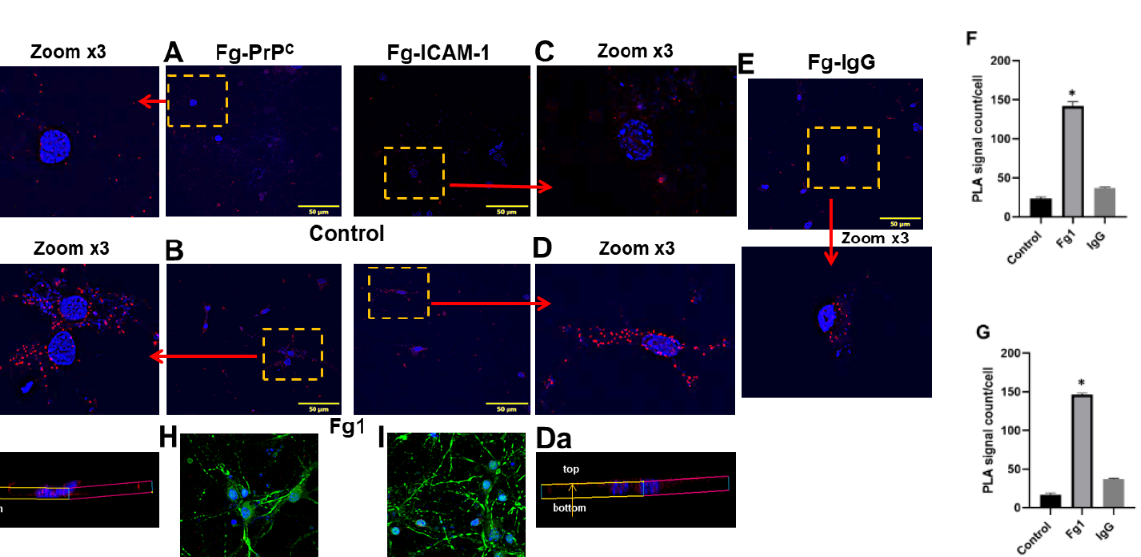
or the ICAM function-blocking antibody alone. Hirudin was present in all experimental groups to prevent the conversion of Fg to fibrin. ( B ) The summary of the image analyses for the detection of live neurons using a live/dead assay. An automatic cell count was performed based on the fluorescence signal threshold of the images provided by the OLYMPUS CellSens Dimension Desktop 2.3. Arrows indicate exemplary dead cells shown in red. Data are presented as the average of number of dead cells as a percent of the total number of cells in a selected constant area of interest in each experimental group.